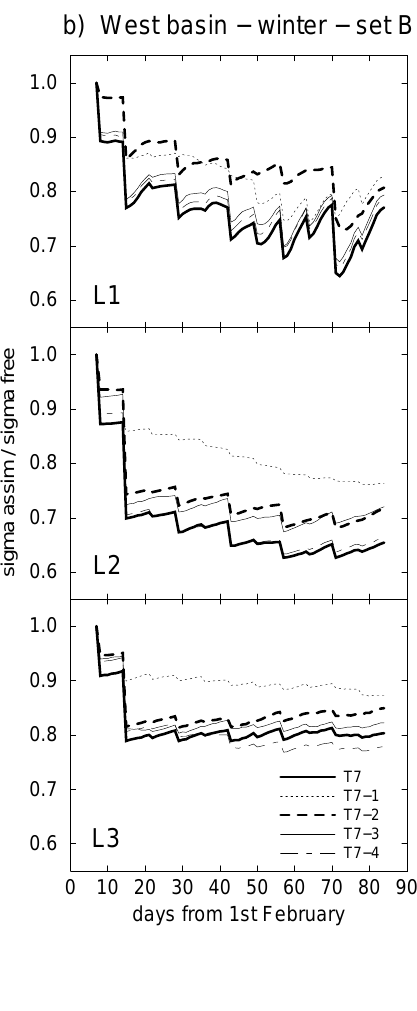
the other sampling strategies, except VT) after 8 assimilation cycles (56 days). The inclusion of track 1 can also be seen as marked error reductions that occur every two assimilation cycles, after the odd cycles (e.g. L1 in Fig. 8b) in the eastern Mediterranean and after the even cycles (e.g. L1 in Fig.